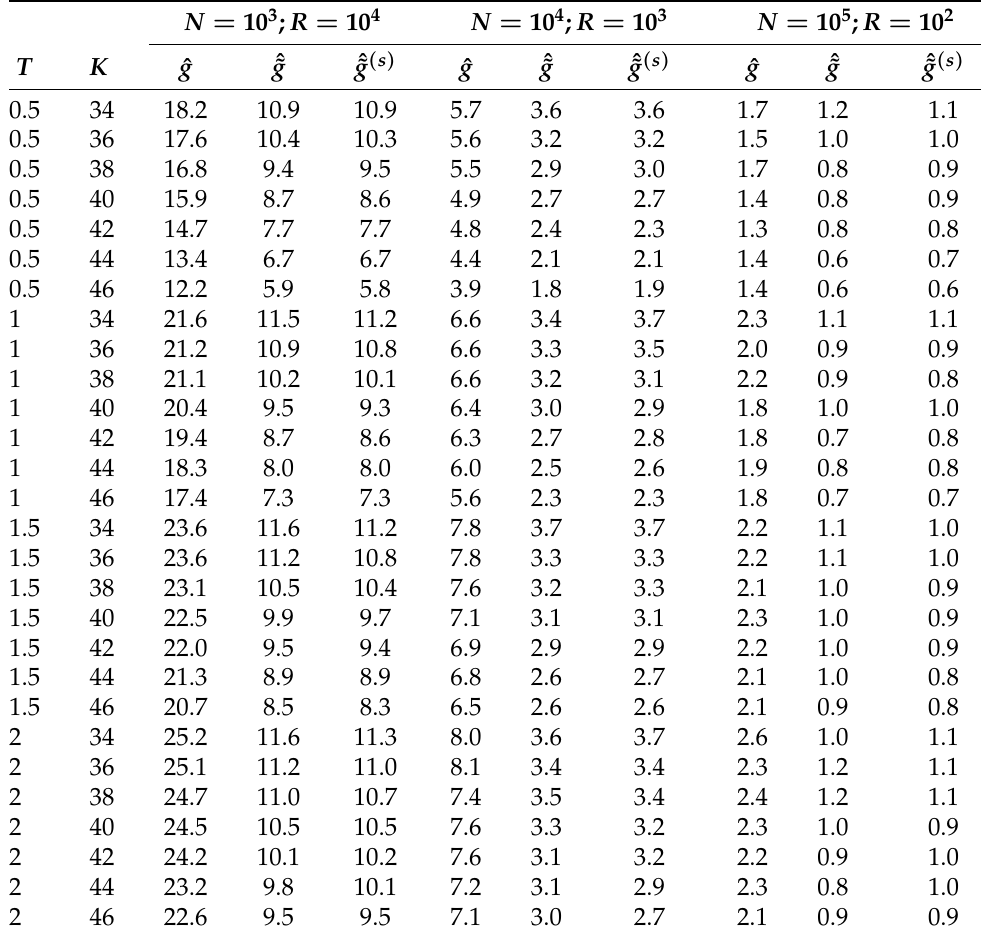
Table A4. Detailed standard deviation results ( × 10 2 ) with GHS